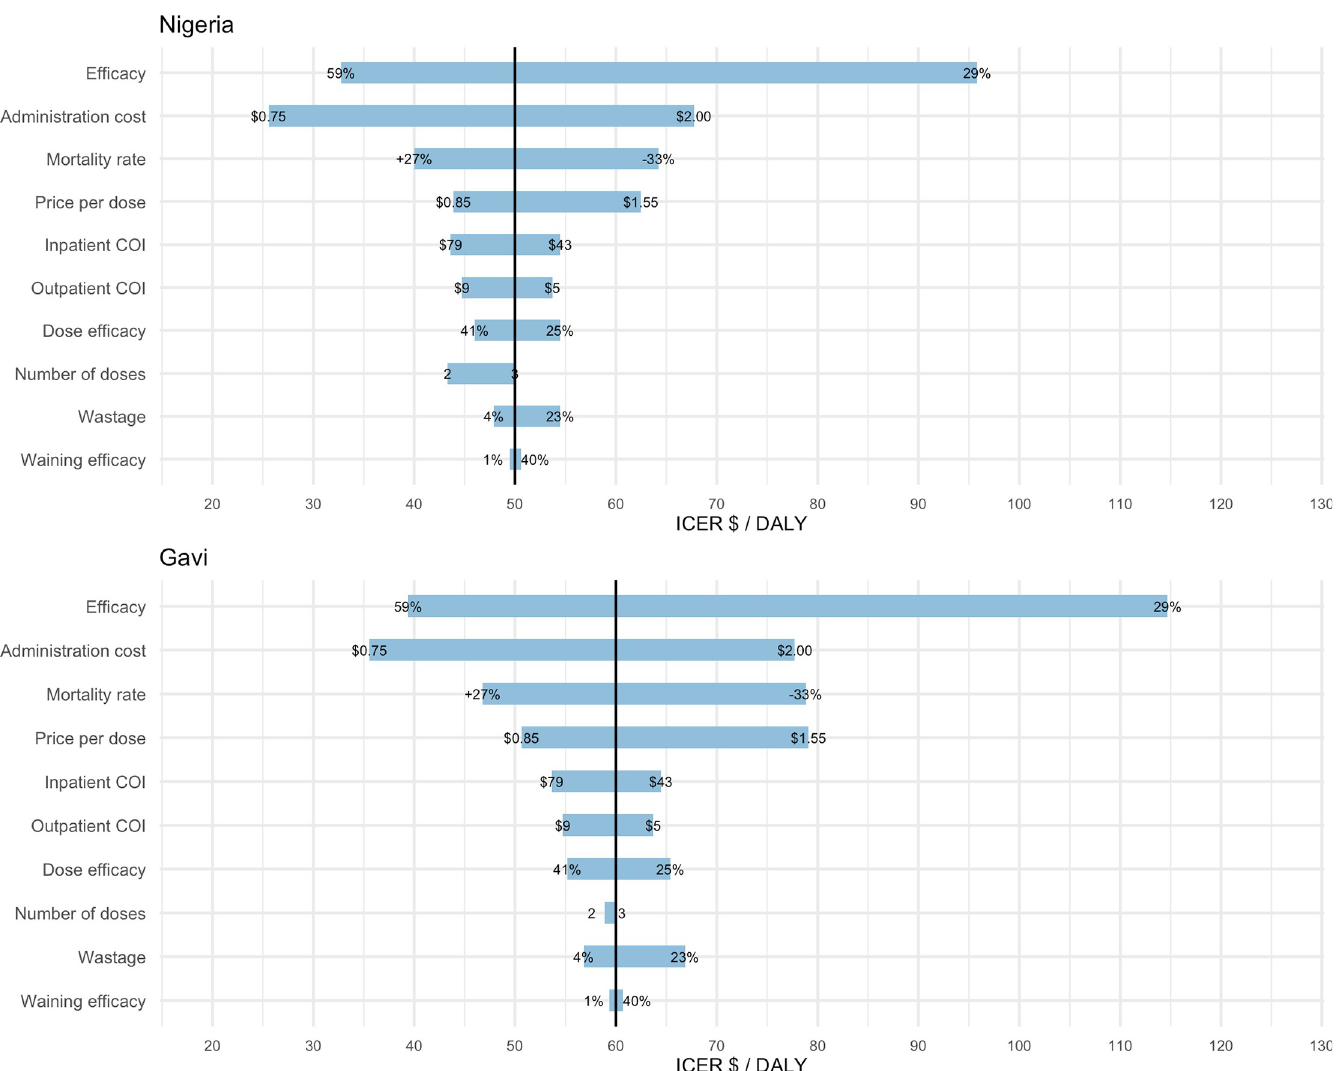
Fig 6. Tornado diagram showing the results sensitivity analysis for vaccination with a general rotavirus vaccine at prices from the Nigerian government perspective (Nigeria) and the Gavi perspective (Gavi). Each input variable and tested assumption is listed on the left axes with corresponding simulated value ranges displayed at the end of each